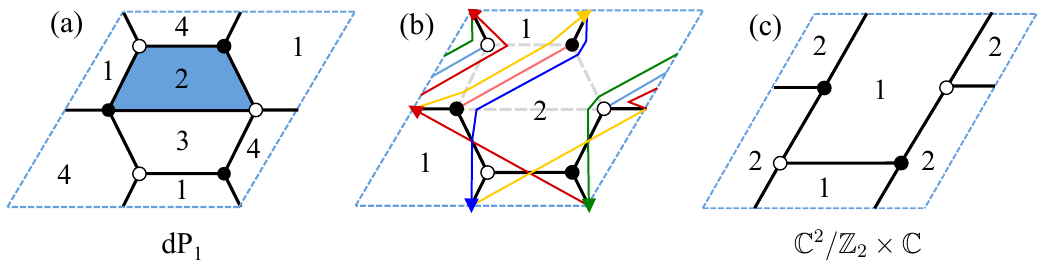
Figure 18. Instanton backreaction from dP 1 to C 2 = Z 2